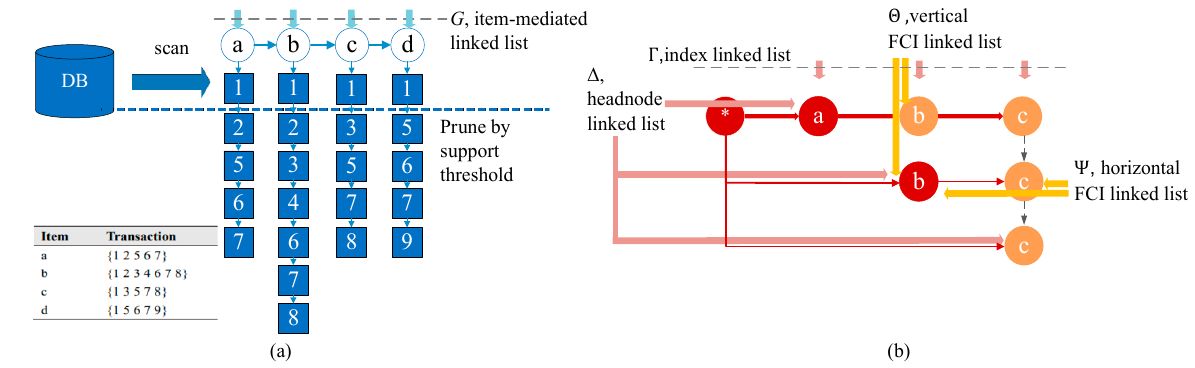
Figure 6. Structures for itemset storage and updating. ( a ) Structure of the item-mediated linked list. ( b ) Structure of the cross-linked structure.